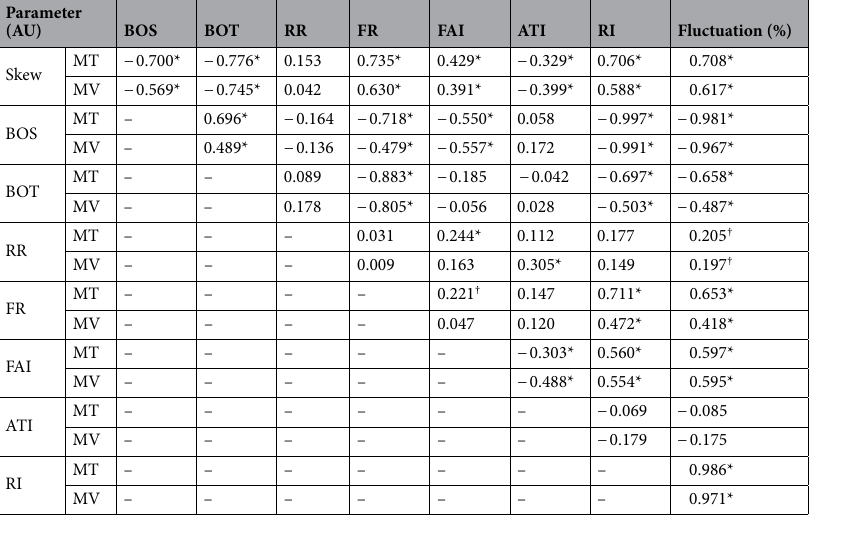
Table 3. Spearman’s rank correlation coefficient between MT- and MV-waveform parameters. ATI acceleration time index, AU arbitrary unit, BOS blowout score, BOT blowout time, FAI flow acceleration index, FR falling rate, RI resistivity index, RR rising rate. * P < 0.01, † P <